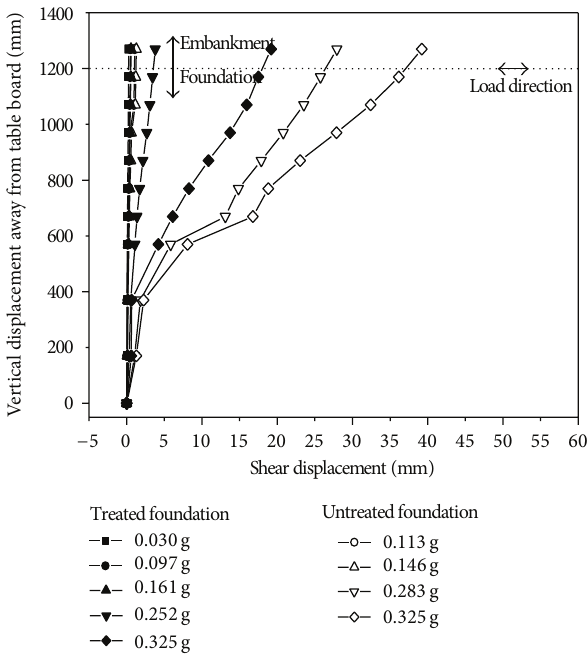
Figure 11: The vertical distribution of foundation shear displace- ment.